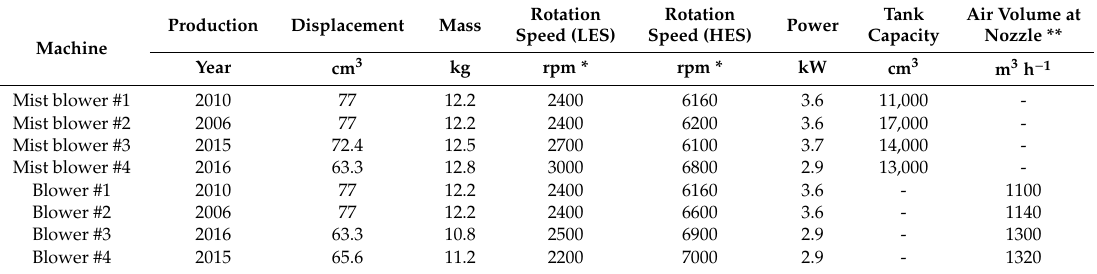
Figure 1. Two tested machines (a mist blower ( a ) and a blower ( b )). Table 2. Technical characteristics of the